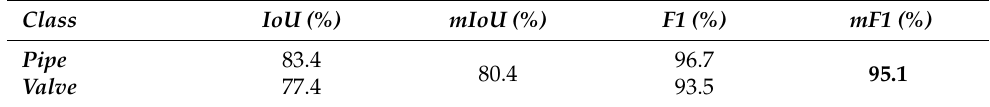
Table 2. DGCNN instance-level metrics on T BASE test set.